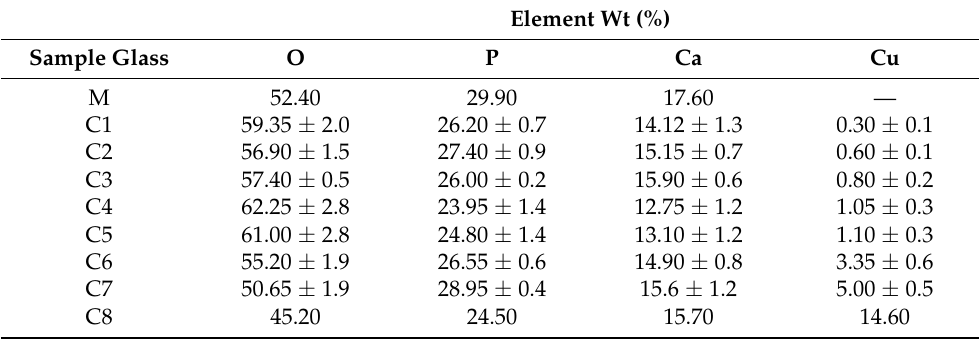
Table 3. The average overall chemical composition of xCuO · (100 − x) [CaF 2 · 3P 2 O 5 · CaO] glass system by EDX